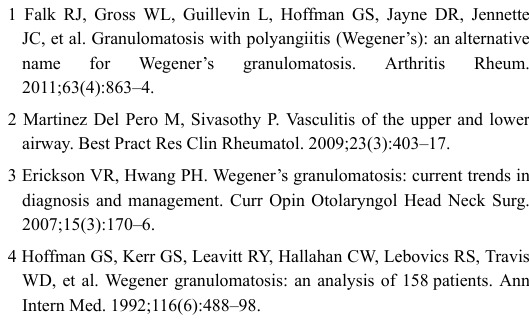
Table 1: Summary of the potential upper respiratory tract manifestations of the main systemic vasculitides.